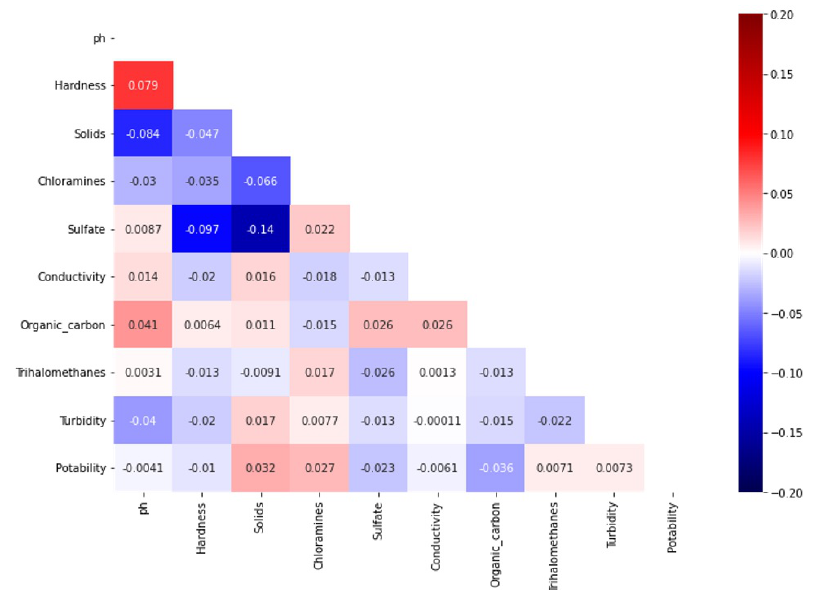
Figure 3. Correlation heatmap of features.